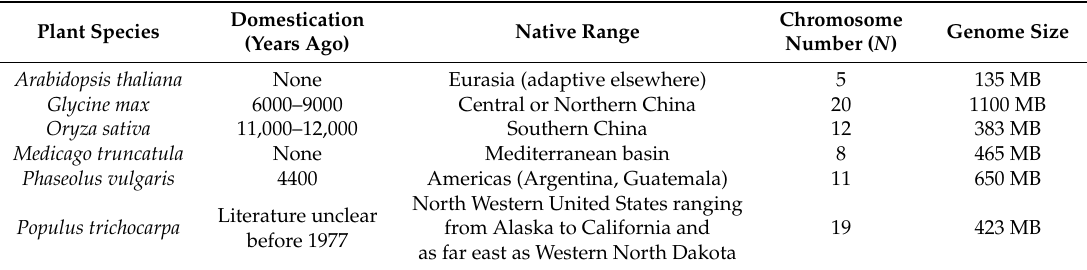
Table 1. Domestication history and genomic information of Arabidopsis [32], Soybean [33], Rice [34], Medicago [35], Common bean [36] and Poplar